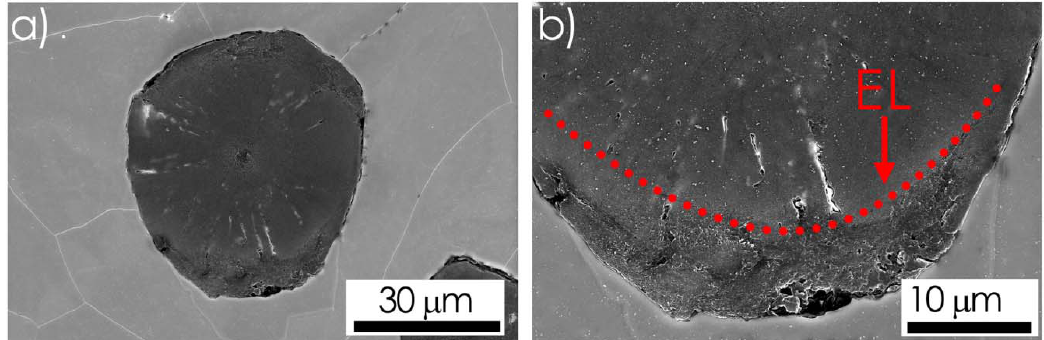
Figure 8. Debonding area at the G ‐ M interface in SNi9 specimen, around a spheroid located near fracture, SEM: ( a ) A pure G ‐ M debonding at poles of spheroid, ( b ) a zig ‐ zag profile at the G ‐ M interface, traces of deformation inside the ferritic matrix.